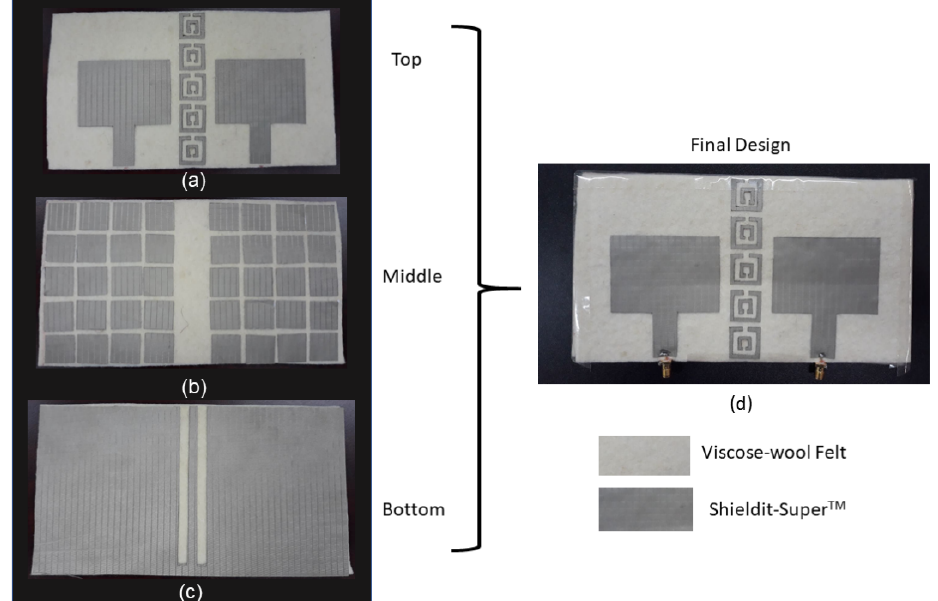
Figure 7. Fabrication MIMO-RIS-EBG antenna using viscose-wool felt and Shieldit-super TM : ( a ) front view of the antenna with substrate 1, ( b ) middle view of the antenna with substrate 2 and ( c ) bottom view of the antenna and ( d ) final antenna design.